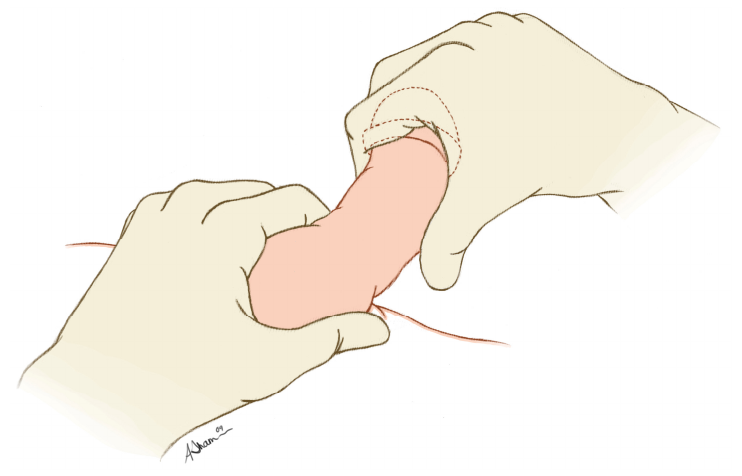
FIGURE 3. Operative modeling of the penis over a penile prosthesis . Manual and forcible bending of the shaft in the direction opposite to the curvature with the prosthesis